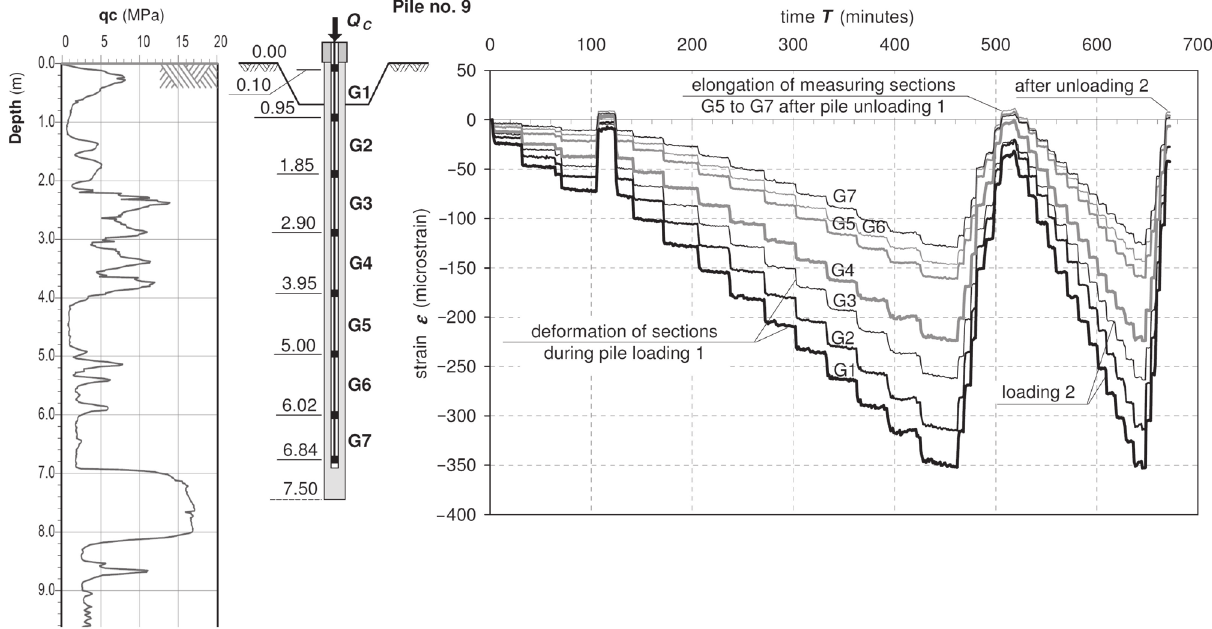
Figure 12: Pile no. 9, graphs of the pile shaft deformation in individual measuring sections and in subsequent stages of pile loading and unloading.